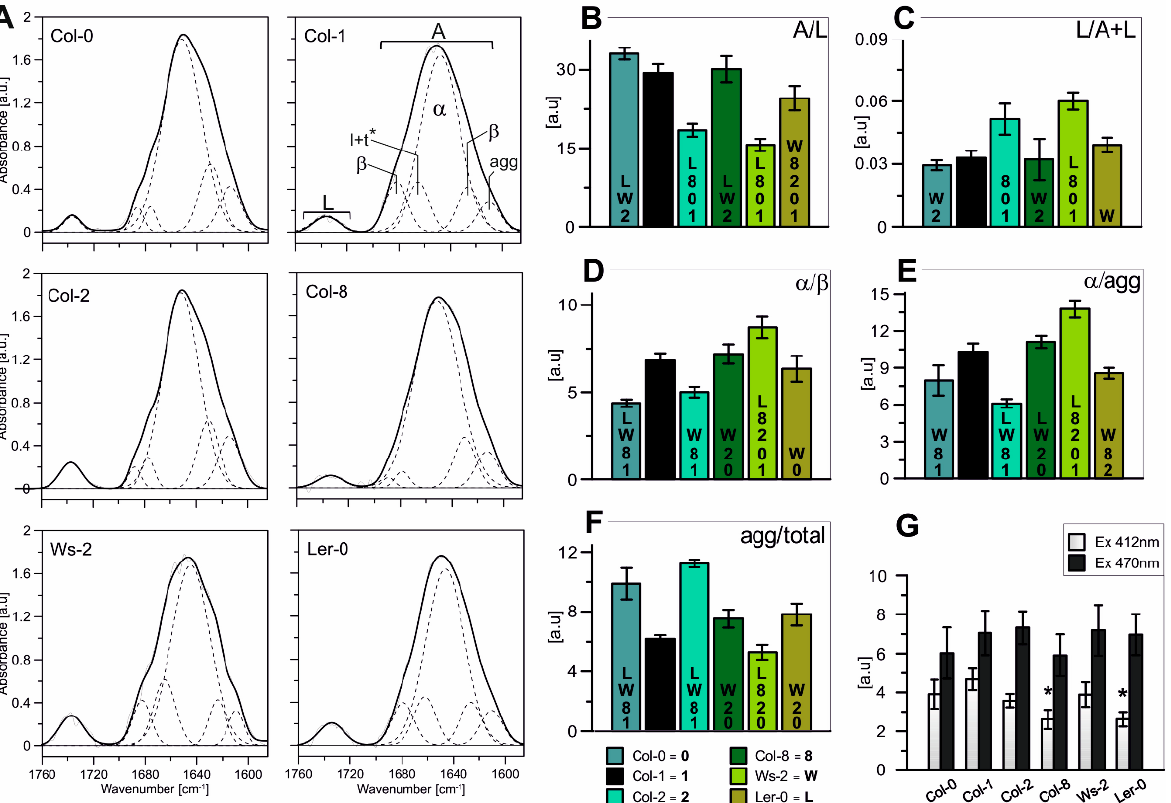
Figure 3. ( A )—Normalized (to 100 AUC) FT-IR spectra in the Amide I and ester C=O regions recorded from isolated thylakoid membranes of all Arabidopsis accessions. The spectra of the Amide I region was divided into five distinct components using the Gaussian fit (shown on the Col-1 absorption spectra) and compared between analysed accessions. ( B )—Ratios of the Amide I region to acyl lipid (ester C=O) band area (A/L). ( C )—The relative amounts of membrane lipids (L/(A + L)). ( D )—Ratios of the α -helis band to the parallel β -structure ( α / β ). ( E )—Ratios of the α -helical band to the aggregated strands ( α /agg). ( F )—Ratio of the aggregated strands to the total band area (agg/total). ( G )—Contribution of the LHC aggregated forms excited at 412 nm (Chl a ) and 470 nm (Chl b ); results marked with an asterisk differ significantly at p = 0.05 from the Col-1 accession. The data are mean values ± SD from three independent experiments. Numbers or capital letters, according to legend, indicating significant differences between accessions ( p < 0.05), i.e., the A/L ratio of Col-0 is significantly bigger than in Col-2 (2), Ws-2 (W), and Ler-0